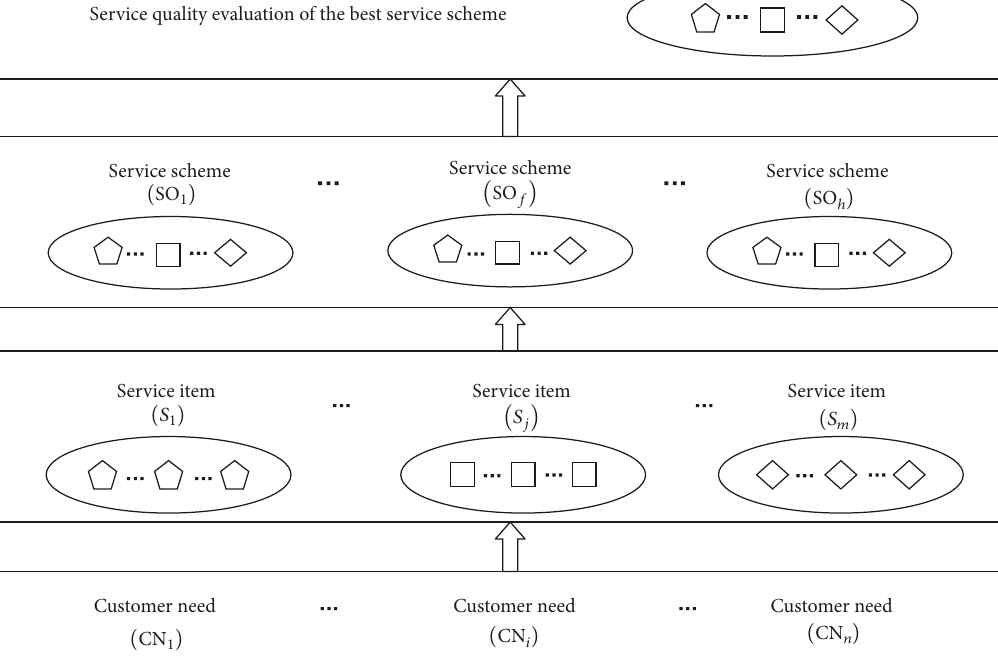
Figure 1: Optimal service plan formation